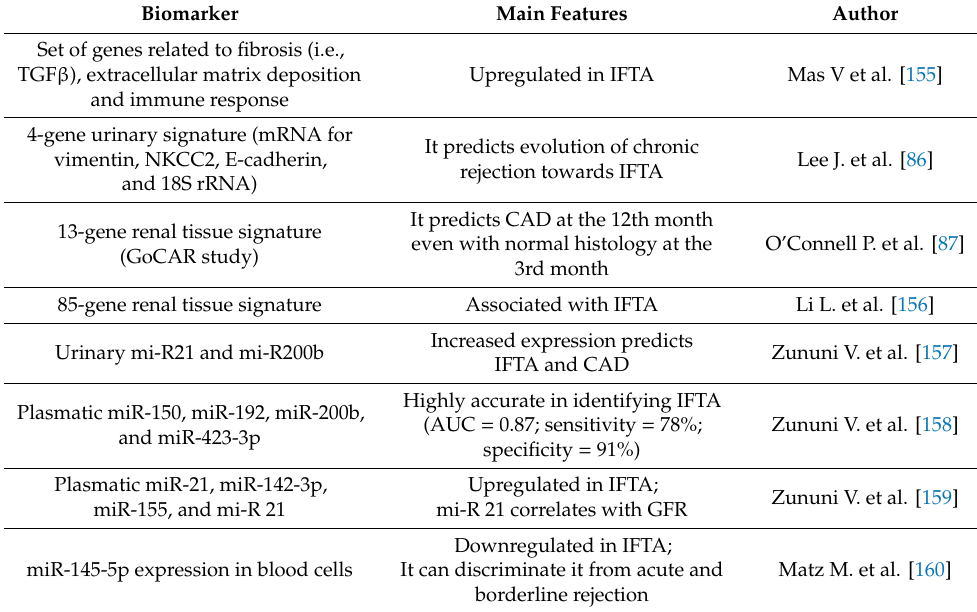
Table 7. Potential biomarkers for chronic rejection and interstitial fibrosis-tubular atrophy (IFTA).